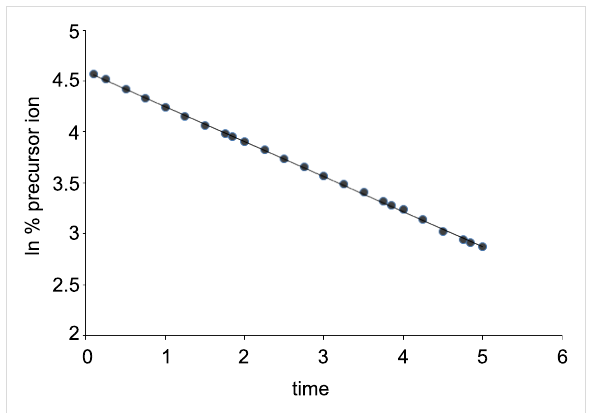
Figure 1: Examples of monoexponential decay: The slope of the line directly provides the reaction pseudo-first-order rate